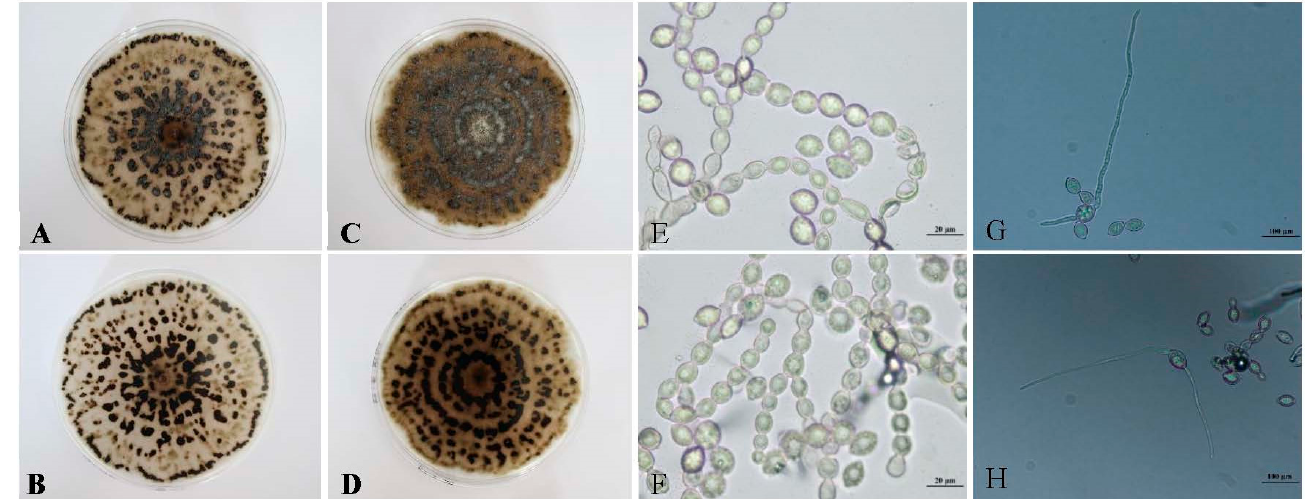
Figure 2. Characteristics of a single-spore isolate of Monilia yunnanensis (isolate T8-1) grown on PDA medium at 22 °C for 13 and 16 days: ( A , B ) front and reverse views of T8-1 colonies at 13 days after inoculation, respectively; ( C , D ) front and reverse colonies of T8-1 colonies at 16 days after inoculation, respectively; ( E , F ) the conidial morphology characteristics of T8-1; ( G , H ) the conidial germ tube morphology characteristics of T8-1.